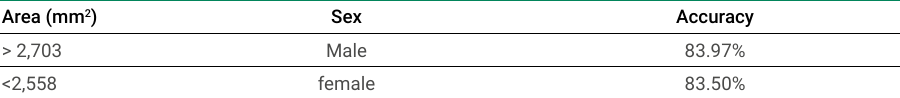
Table 4. Sex determination accuracy and area values for male and female Area (mm 2 ) Sex Accuracy > 2,703